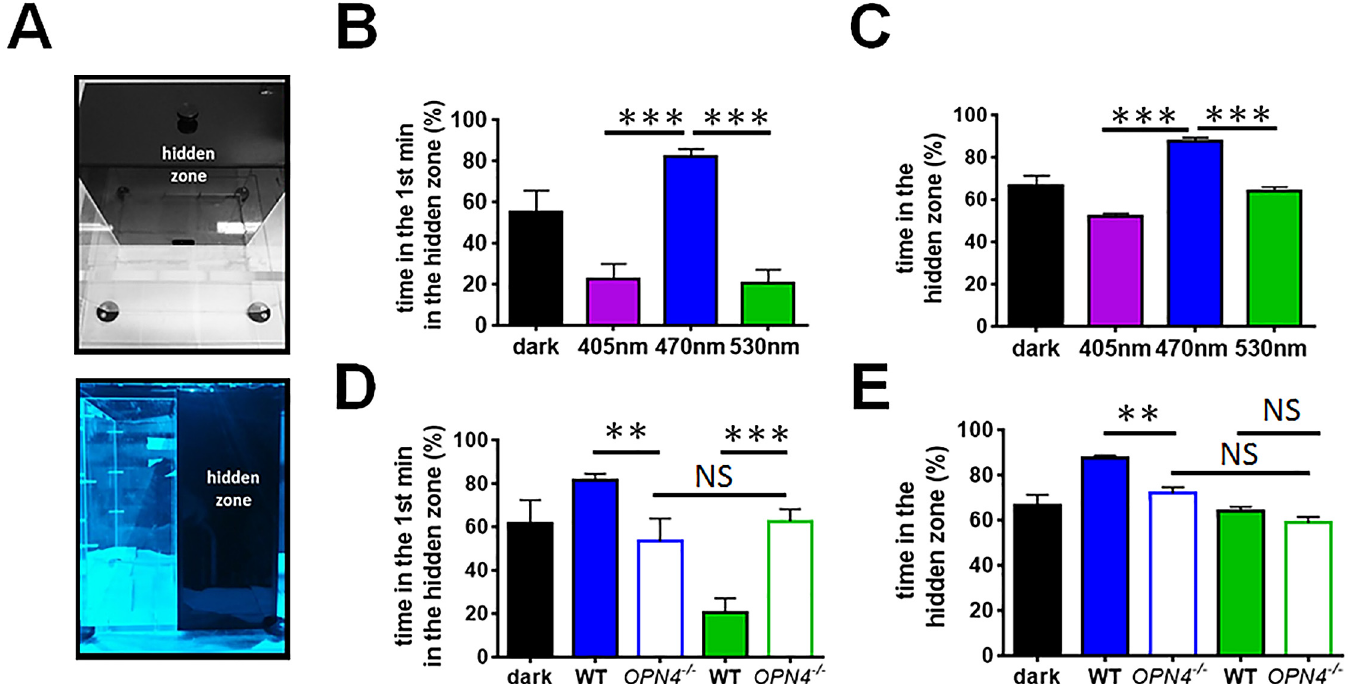
Fig 3. Wavelength-dependent effects on behavioural light aversion. ( A ) Mice entrained to an LD12:12 cycle were exposed to 405 nm (violet), 470 nm (blue), and 530 nm (green) light at ZT14 in a light/dark box for 10 min. ( B ) In the first 1 min of the test, mice spent significantly more time in the hidden zone under blue light compared to violet, green, or control (dark) conditions. One-way repeated measures ANOVA for light condition, F (3.25) = 20.696, p (cid:1) 0.001. Post hoc Tukey dark versus violet p = 0.006, dark versus blue p = 0.021, dark versus green p (cid:1) 0.001, blue versus violet p (cid:1) 0.001, blue versus green p (cid:1) 0.001. ( C ) In the following 9 min, mice exposed to blue light continued to spend more time in the hidden zone compared to violet or green light. One-way repeated measures ANOVA light condition over time 2 – -10 mins, F (3,25) = 11.721, p (cid:1) 0.001. Post hoc Tukey dark versus violet p = 0.635, dark versus blue p = 0.021, dark versus green p = 0.635, violet versus blue p (cid:1) 0.001, blue versus green p (cid:1) 0.001. ( D ) Opn4 -/- mice (open bars) showed different responses to both blue and green light. In the first minute of the test, in comparison with wildtype mice, Opn4 -/- mice spent less time in the hidden zone in response to blue light. However, Opn4 -/- animals spent more time in the hidden zone compared with wildtype under green light. Two-way repeated measures ANOVA for light condition and genotype, light condition x genotype interaction F (1,26) = 20.585, p (cid:1) 0.001. Post hoc Tukey wildtype versus Opn4 -/- blue p = 0.010, green p = 0.001. ( E ) Whilst the attenuated response to blue light in Opn4 -/- mice persisted over the remaining time course of the test (one-way repeated measures ANOVA for effect of genotype over time, F (1.13) = 14.376, p = 0.002), no difference was observed between wildtype and Opn4 -/- mice under green light (one- way repeated measures ANOVA for effect of genotype over time, F (1.13) = 0.26, p = 0.617). Opn4 -/- mice showed no statistical difference in responses to wavelength in the first minute or whole time of the test (one-way repeated measures ANOVA for effect time over wavelength F (9,81) = 0.976 p = 0.466). Histograms reflect mean percentage ± SEM of time spent in the dark box of the light dark box during the 10 min trial ( n = 6 – -10/group wildtype, n = 4 – -10 Opn4 -/- ). Significant differences indicated by *** p (cid:1) 0.001, ** p (cid:1) 0.01, * p (cid:1) 0.05, NS = not significant. The data used to make this figure can be found in S3 Data.